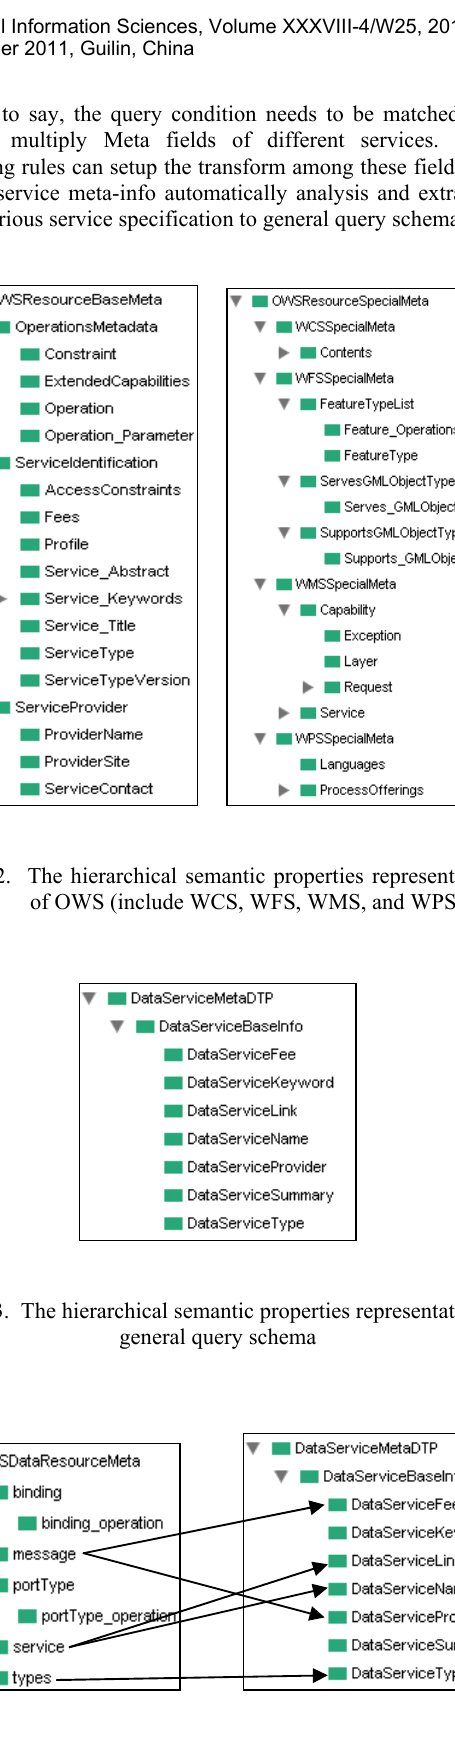
Figure 4. The mapping relations of semantic properties between WSDL and general query